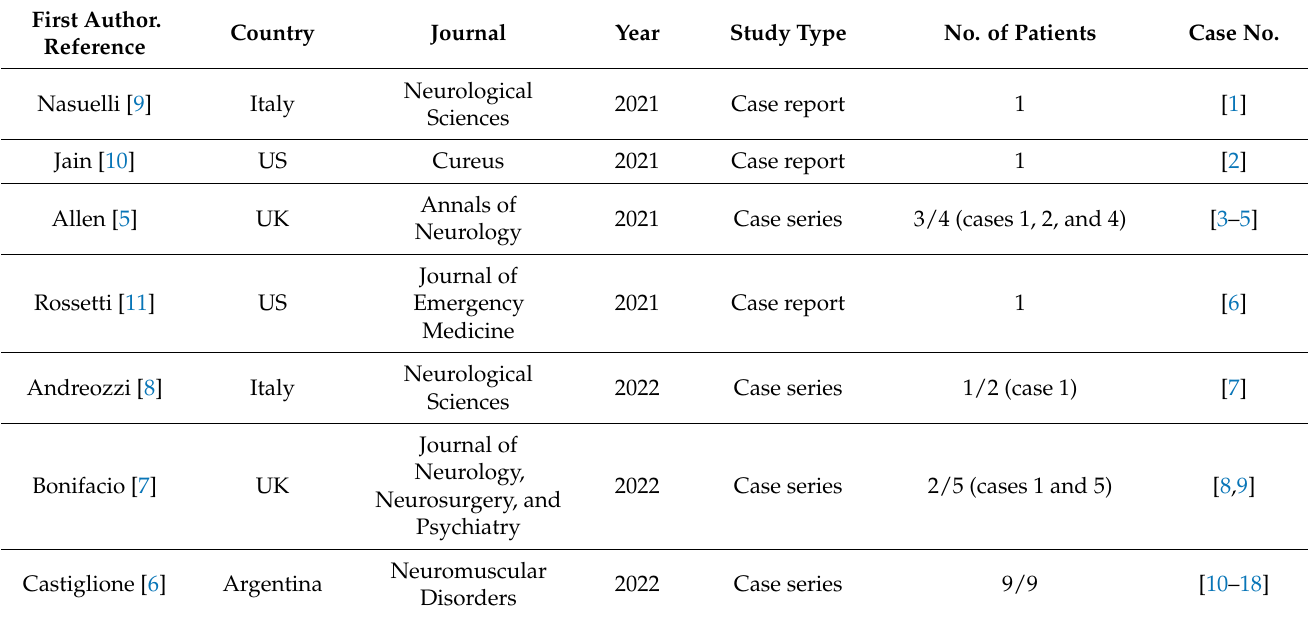
Table 1. Summary of enrolled studies.